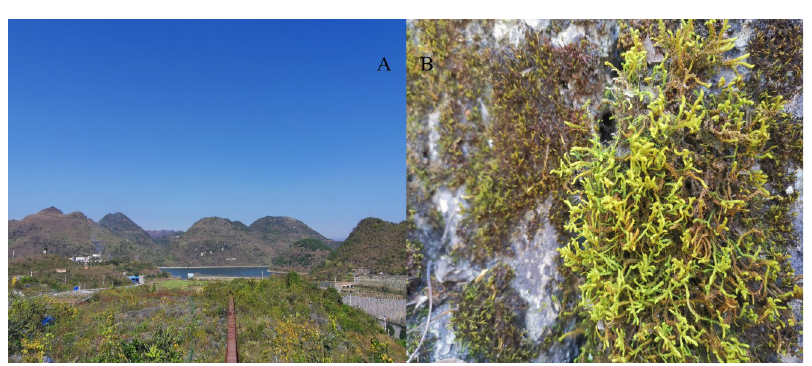
Fig 2. The map of the ecosystem of Puding karst rocky desertification ecosystem observation and research station of the chinese academy of sciences. A show the habitat of karst rocky desertification. B shows mosses in the karst rocky desertification